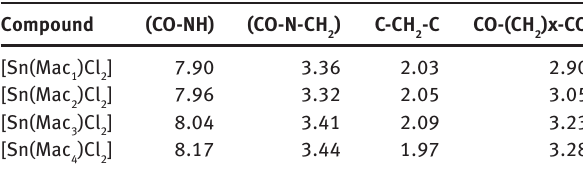
Table 4 Antifungal screening data of tin(II) macrocyclic complexes.